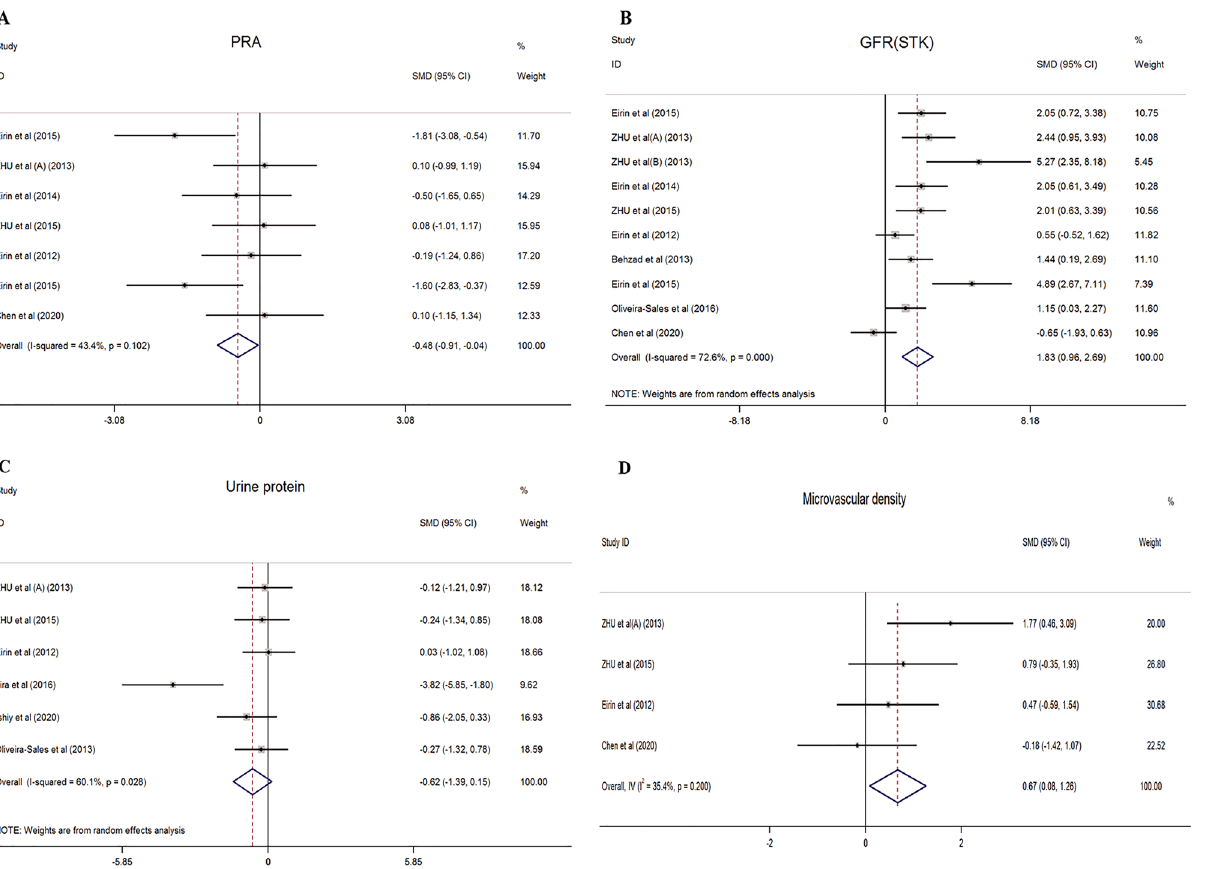
Figure 3. The effect of MSC therapy on plasma renin activity ( A ), glomerular filtration rate of stenotic kidney ( B ), urine protein ( C ) and microvascular density ( D ) in preclinical